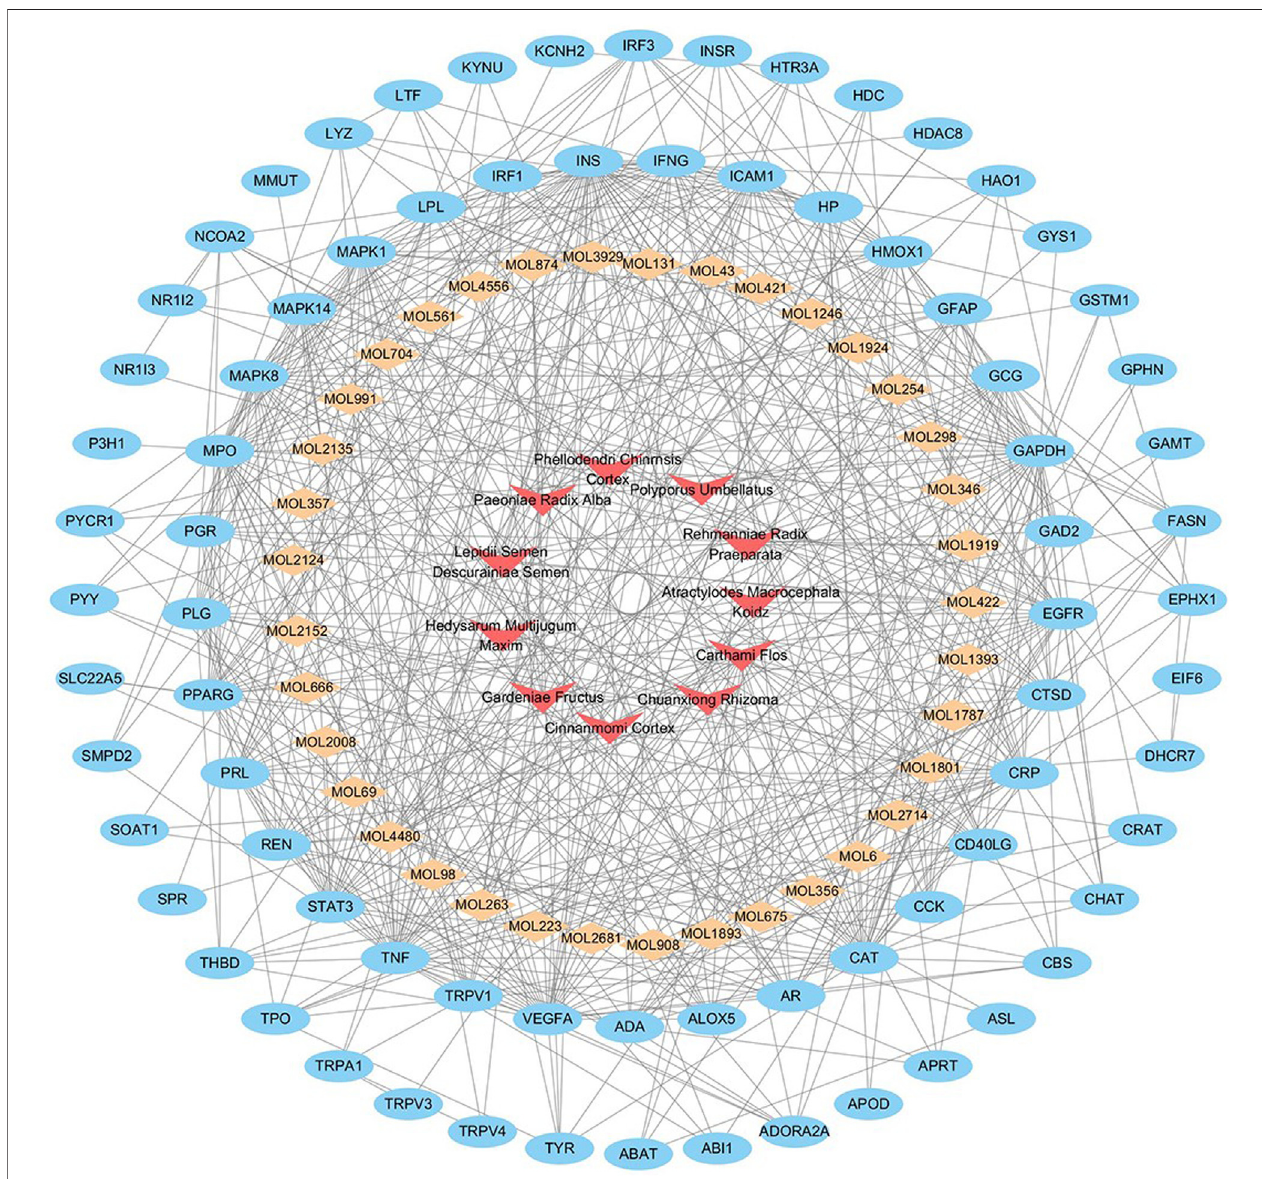
FIGURE 8 | Herbs-compounds-targets network of NFPX on ARDS. The red arrow represents herbs in NFPX; the orange diamond represents the bioactive compounds of NFPX; the blue ellipse represents the target genes.